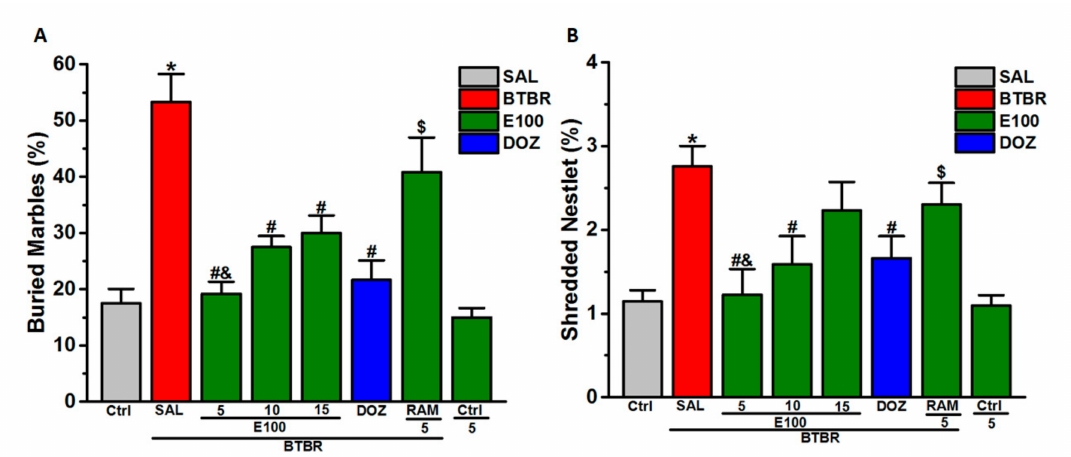
Figure 2. E100 mitigated stereotyped repetitive behavior in marble burying behavior (MBB) and attenuated increased obsessive-compulsive features in nestlet-shredding test (NST). ( A ) Repetitive marble-burying and ( B ) obsessive compulsive nestlet-shredding behavioral observations were evaluated after a 30-min testing session. BTBR mice (red) showed significant elevated stereotyped, repetitive and compulsive behaviors compared to Ctrl mice (gray). All mice were administered subchronically for 21 days with E100 (at a dose of 5, 10 or 15 mg / kg, i.p in green) or DOZ (1 mg / kg, i.p. in blue). E ff ects of subchronic (21 days) systemic co-injection of RAM (10 mg / kg, i.p.) on the E100 (5 mg)-provided decrease of stereotyped repetitive and compulsive behaviors of BTBR mice were displayed in (A) MBB and (B) NST. Values are expressed as mean ± SEM (n = 6). * p < 0.05 compared to saline-treated Ctrl mice. # p < 0.05 compared to saline-treated BTBR mice. & p < 0.05 compared to E100 (10 or